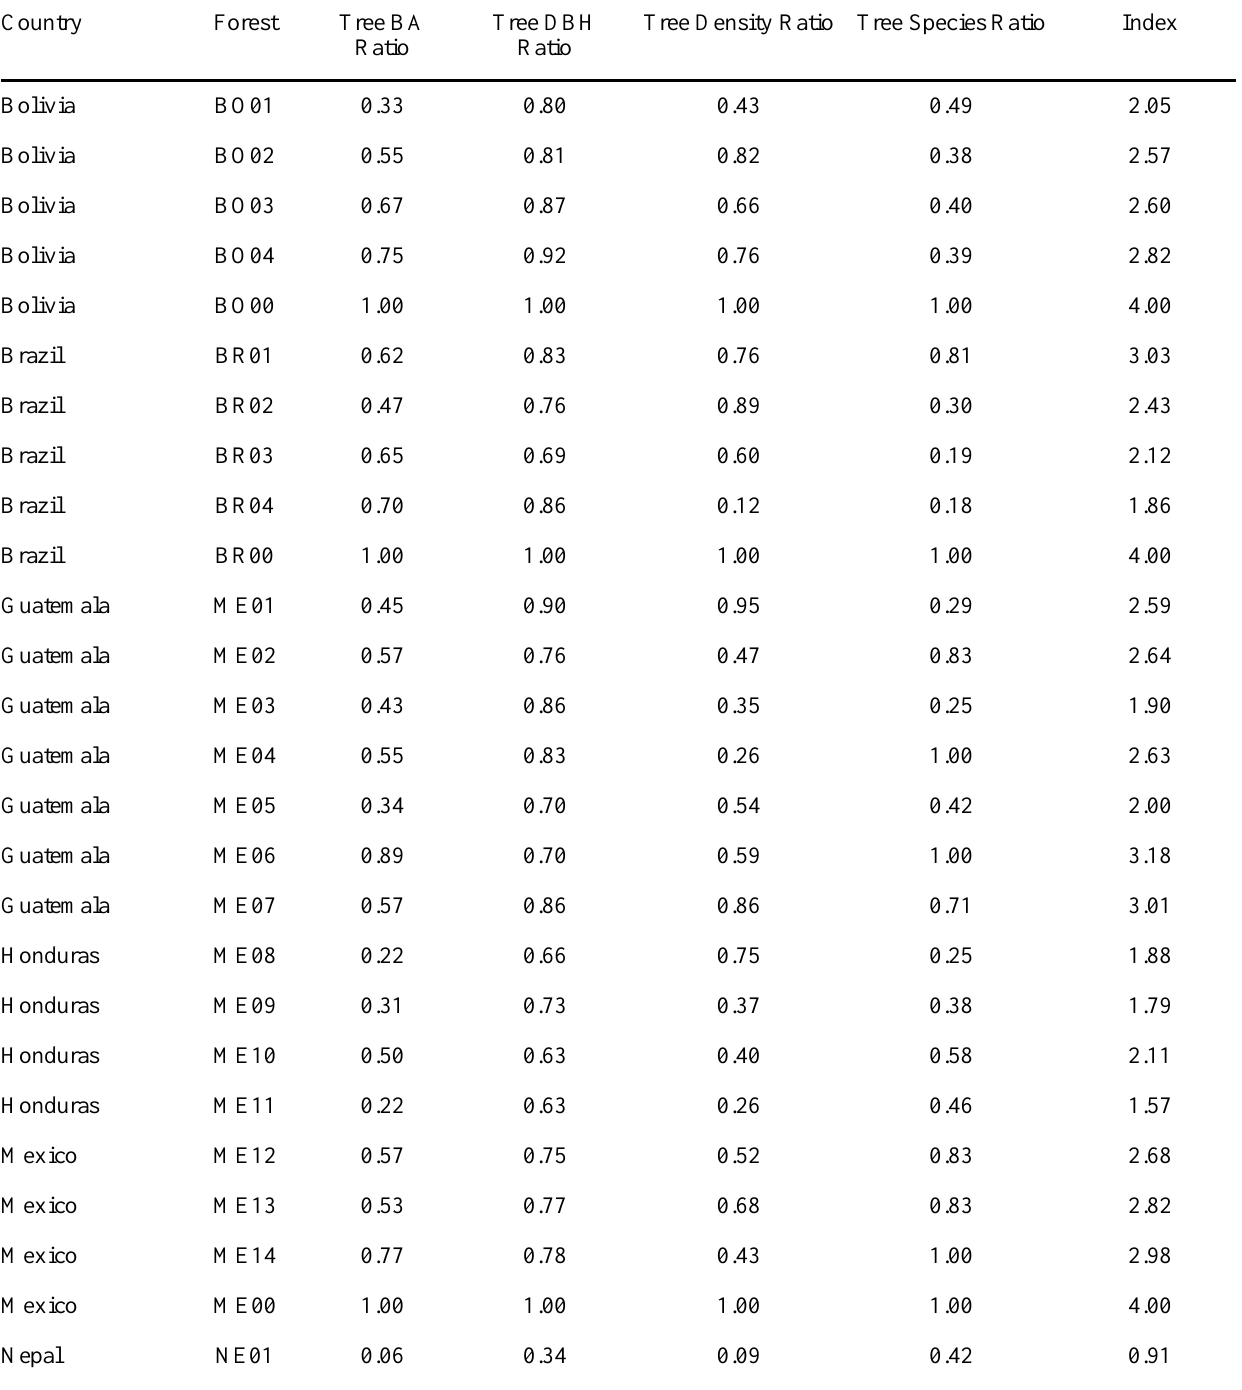
Table 2. Index of disturbance calculated for each study forest relative to the reference forest in each